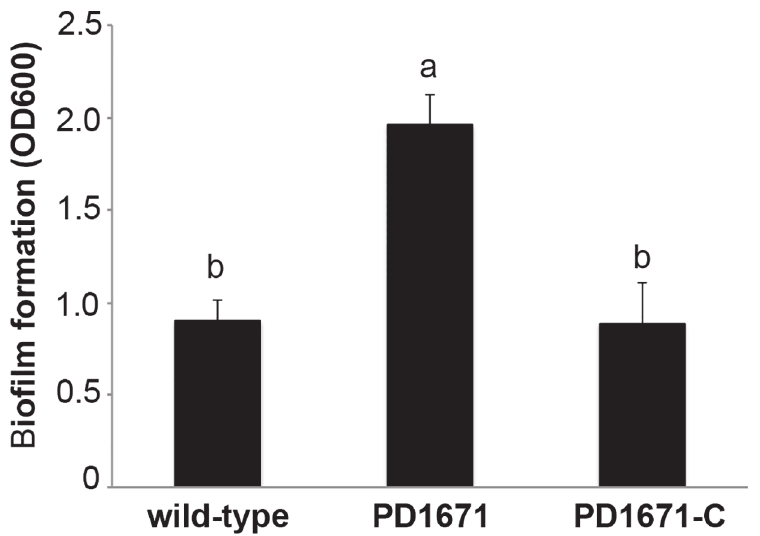
Fig 4. Biofilm production by the X . fastidiosa PD1671 mutant. Quantification of biofilm formation in Vitis vinifera xylem sap with agitation for wild-type X . fastidiosa Temecula 1, PD1671 mutant, and complemented PD1671 mutant (PD1671-C). Representative experiment shown. Different letters represent significant difference when means are compared ( P =